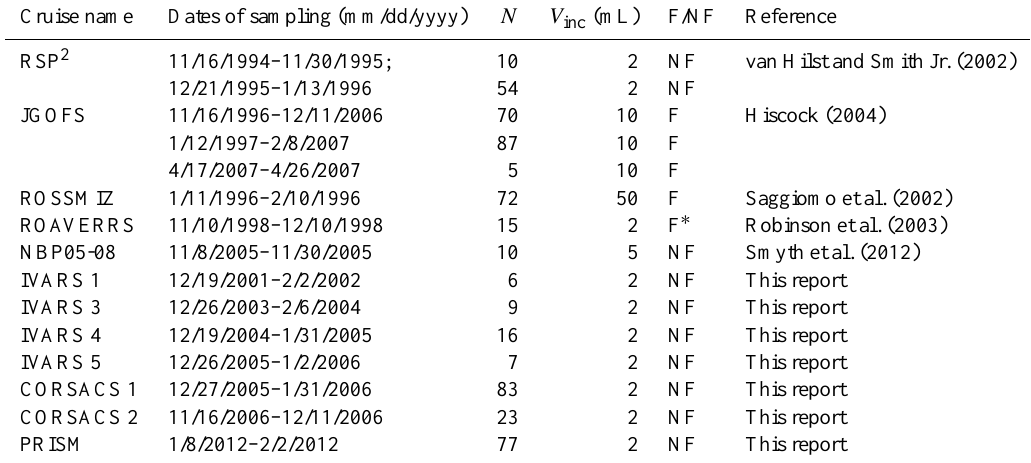
Table 1. Listing of photosynthesis–irradiance responses used in this meta-analysis. N : number of determinations; V inc : volume incubated; F/NF: filtered/not filtered.